Question: Does the figure show an increasing or a decreasing trend?
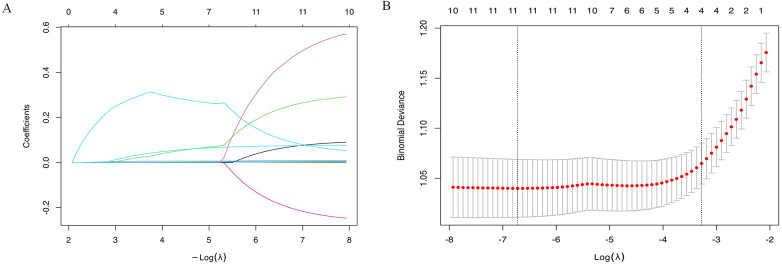
Answer: increasing